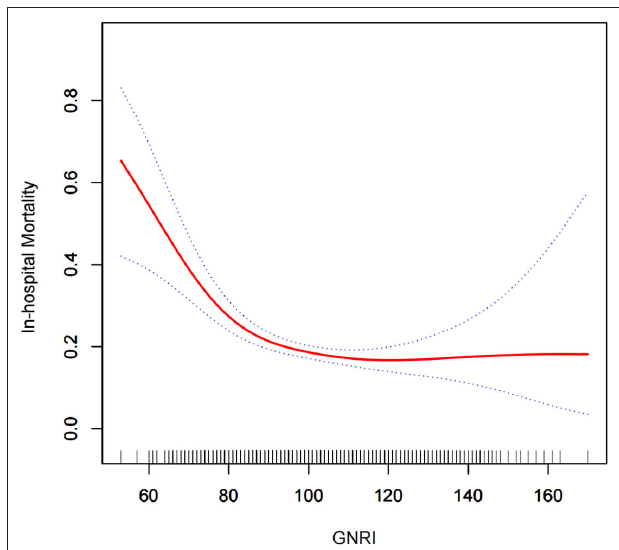
FIGURE 2 | Relationship between GNRI and death during hospitalization. The curve fitting equations of death (Y) and GNRI (X) during hospitalization are used. A non-linear relationship is observed between Y and X, and the slope changes evidently, which may have a threshold saturation effect.